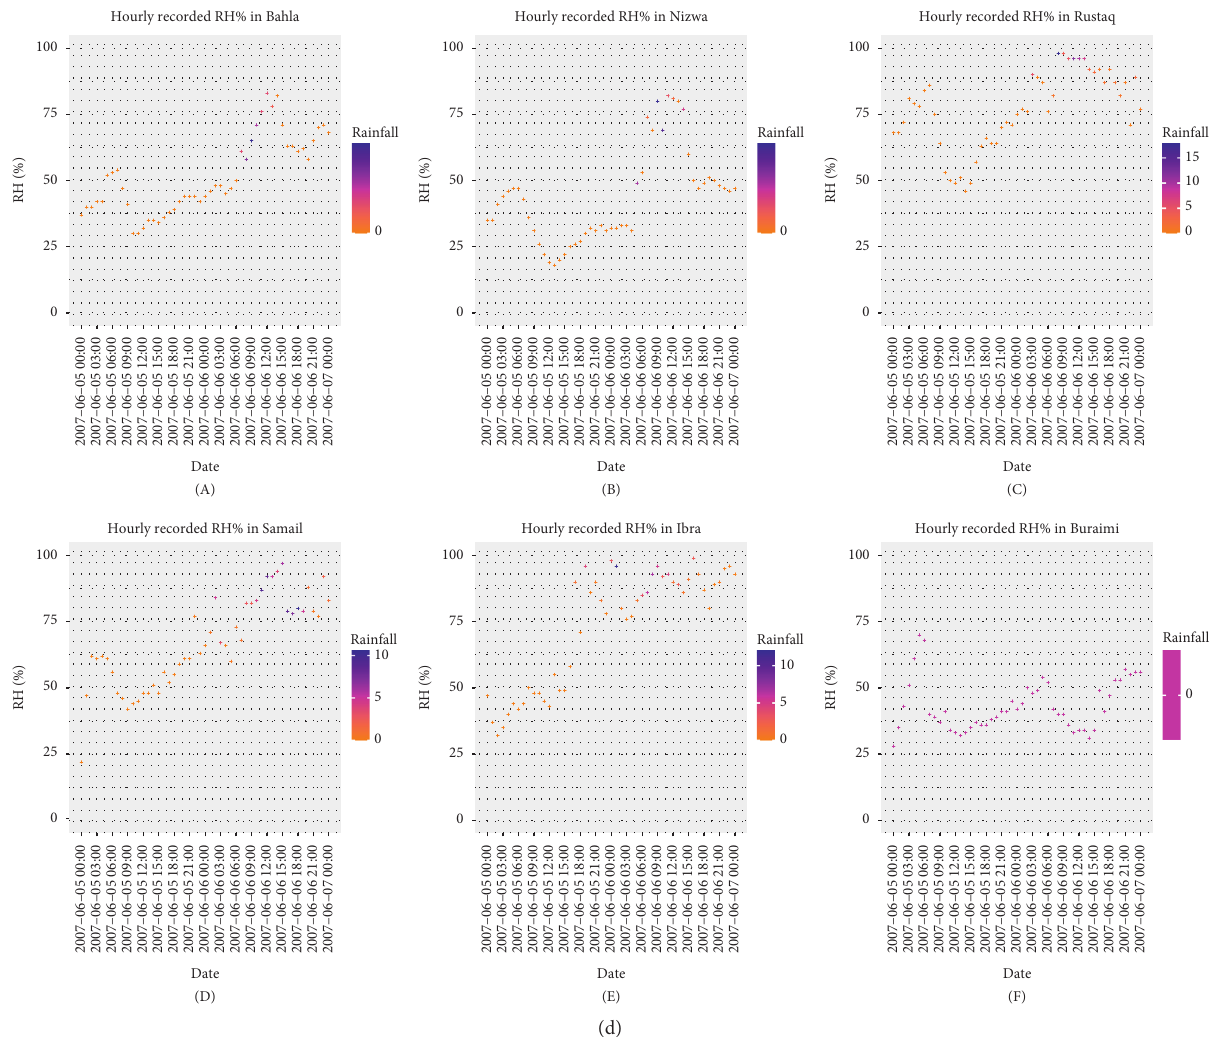
Figure 7: (a) Hourly temperature variation in ° C with respect to the wind direction at some weather stations on the Al-Hajar Mountains during TC “Gonu.” (b) Hourly precipitation (mm) at some weather stations on the Al-Hajar Mountains during TC “Gonu.” (c) Daily precipitation (mm) at some weather stations on the Al-Hajar Mountains during TC “Gonu.” (d) Hourly RH% variation with respect to the wind direction at some weather stations on the Al-Hajar Mountains during TC